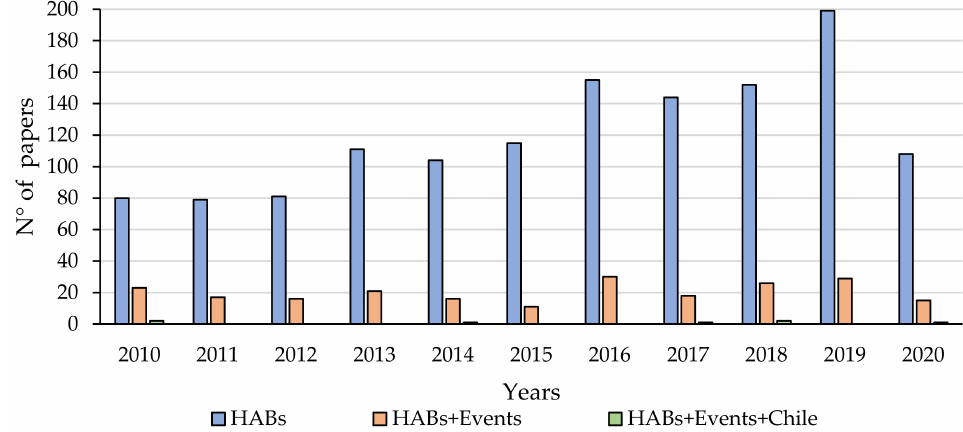
Figure 1. Number of papers associated with the keywords HABs and the combinations of HABs + Events and HABs + Events + Chile.